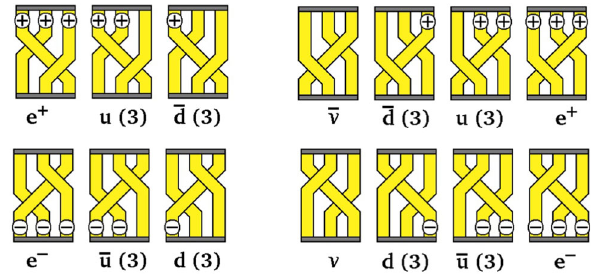
Fig. 1 In thebraidmodel, leptons andquarks are representedasbraids of three twisted ribbons, restricted by certain rules. Source, [3]